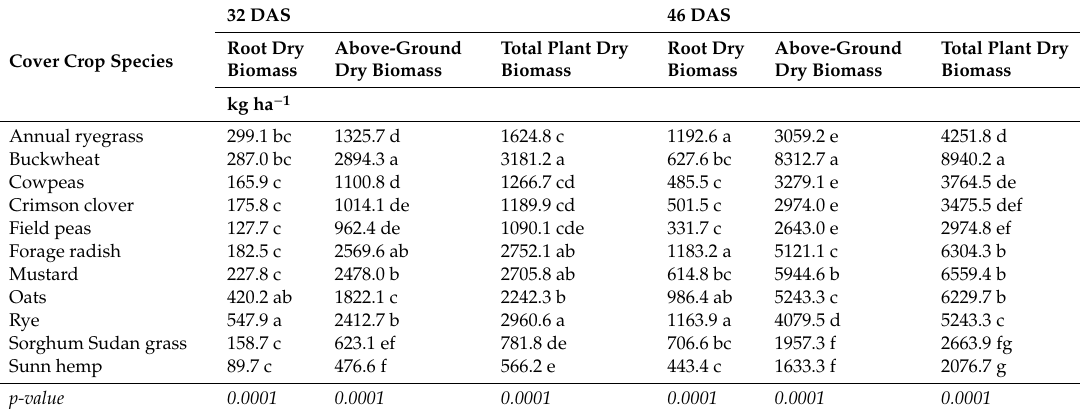
Table 2. Root, above-ground and total plant dry biomass of selected cover crop species 32 and 46 days after sowing (DAS) 1